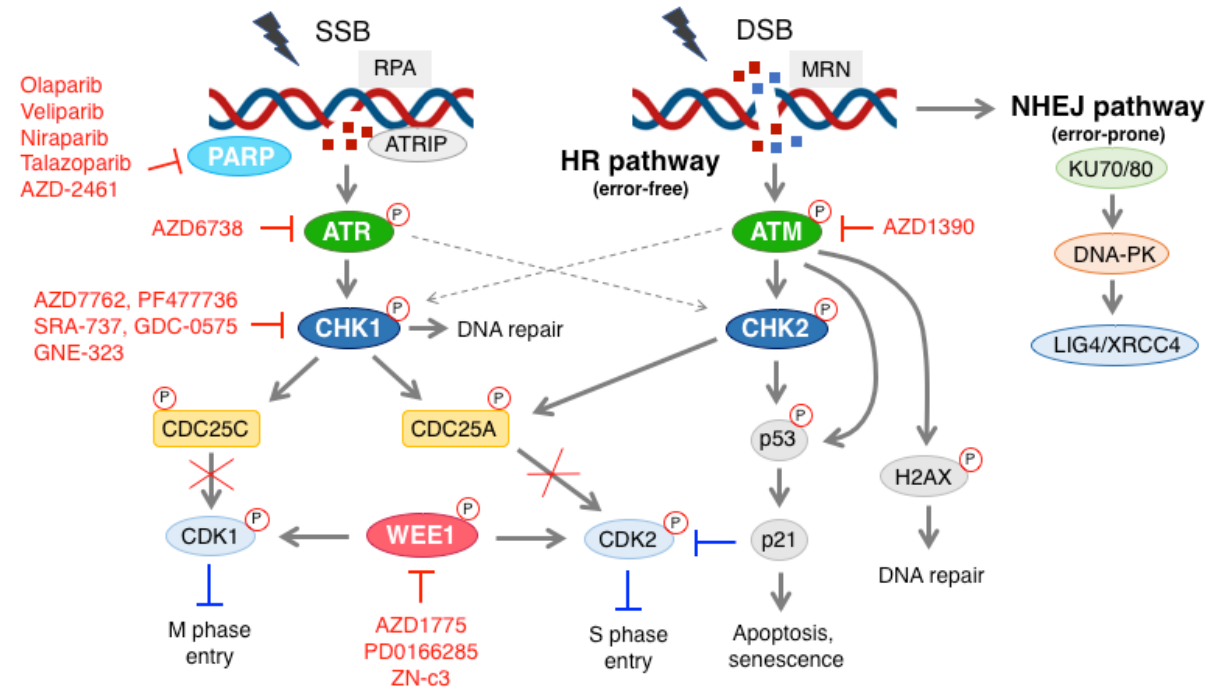
Figure 1. Schematic representation of the DDR pathway and DDR inhibitors used in preclinical and clinical settings in melanoma. Single strand break (SSB) is recognized by the RPA complex, which leads to the activation of ATR and CHK1. The latter promotes phosphorylation and inactivation of the phosphatases CDC25A and CDC25C, which are involved in dephosphorylation and activation of CDK2 and CDK1, respectively. CHK1 may also be activated by ATM. WEE1 regulates the CDKs activity in a negative manner, playing an essential role in controlling S and M phase entry. The MRN complex recognizes double strand break (DSB), and activates ATM. CHK2 and p53 are the main targets of ATM. Upon activation, CHK2 and p53 can lead to either cell cycle block or apoptosis. Active ATM can also phosphorylate H2AX, which can lead to DNA repair. During SSB formation, ATR can also activate CHK2. PARP, ATR, CHK1, ATM and WEE1 inhibitors are indicated in red. More information about these inhibitors is reported in the main text. DSB can also activate the NHEJ pathway, whose main components include KU70/80, DNA-PK and LIG4/XRCC4. P with red circles stands for phosphorylation.